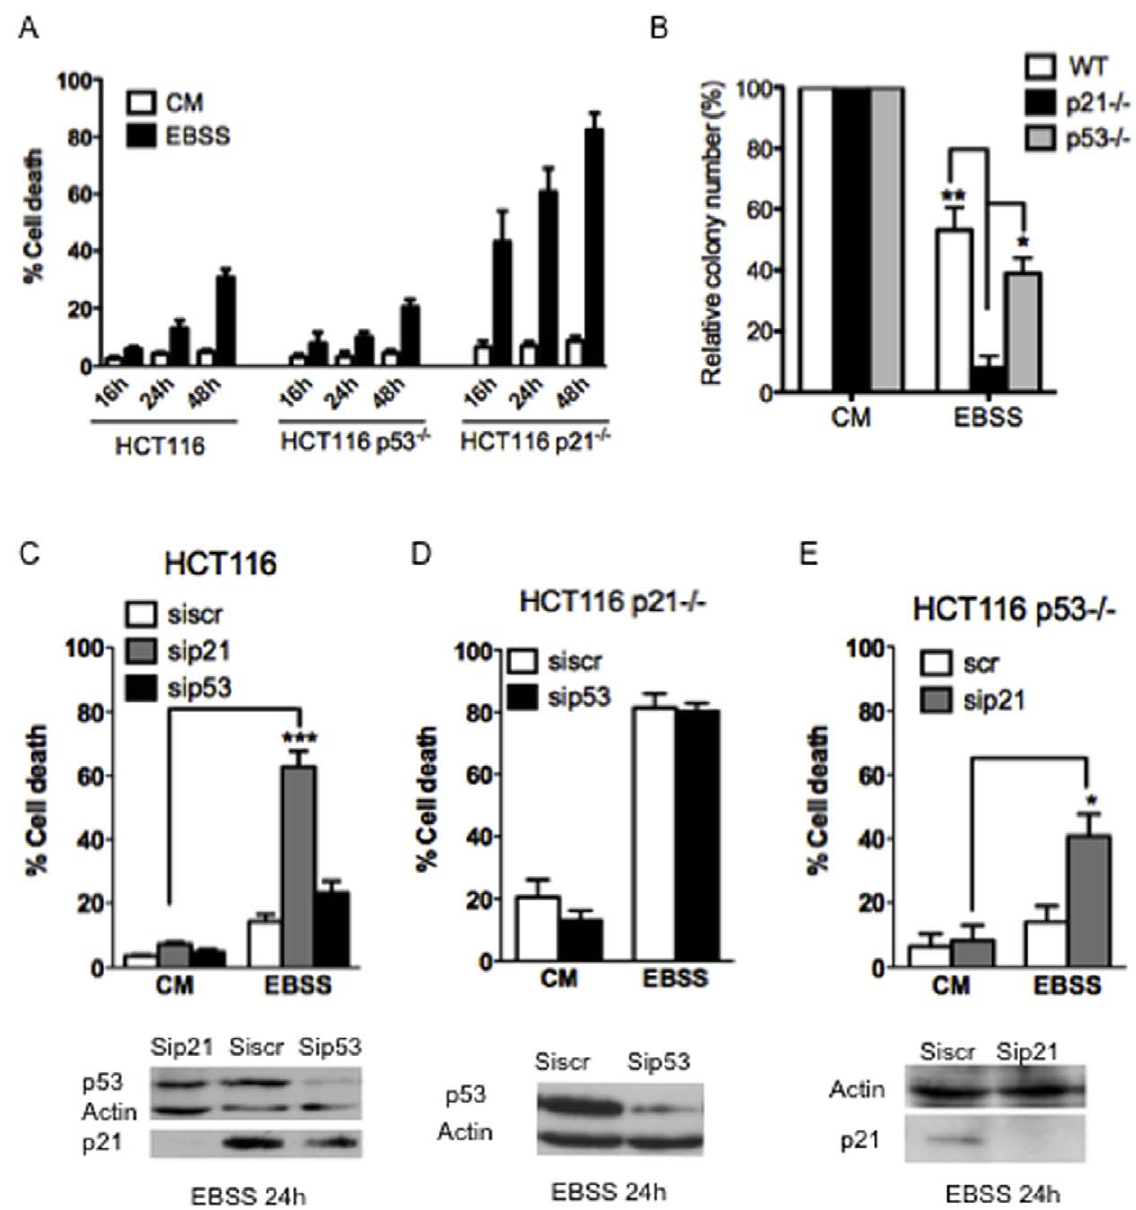
Figure 1. Role of p21 and p53 in cell death induced by serum nutrient starvation. (A) The indicated cells were placed in complete medium (CM) or in starved medium for 16 h, 24 h or 48 h (EBSS) and cell death was assayed by a trypan blue-staining. Data presented are mean 6 SEM of three independent experiments. (B) The indicated cells were placed in complete medium (CM) or in starved medium during 24 h and then seeded at a low density for 2 weeks in complete medium before visualization of viable clones by crystal violet staining. (C, D and E) The indicated HCT116 cells were transfected with the indicated siRNA. 48 h later, cells were starved in EBSS medium for 24 h (EBSS) or not (CM). Western blot analysis was performed to confirm silencing and cell death was assayed by a trypan blue-staining. Data presented are mean 6 SEM of three independent experiments.